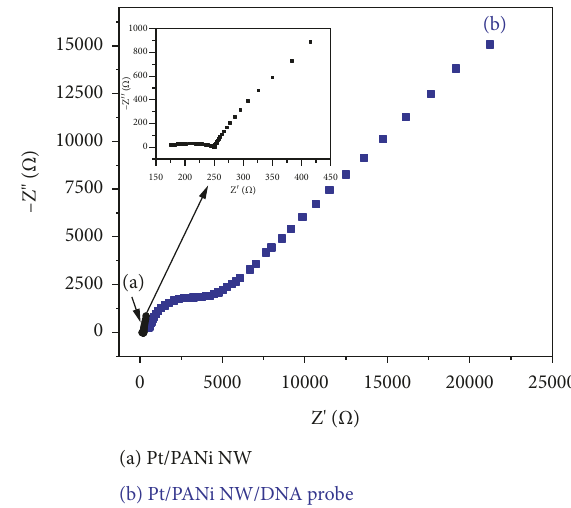
Figure 4: EIS spectra (Nyquist plots) of (a) Pt/PANi NWs and (b) Pt/PANi NW/probe DNA microelectrodes measured in PBS